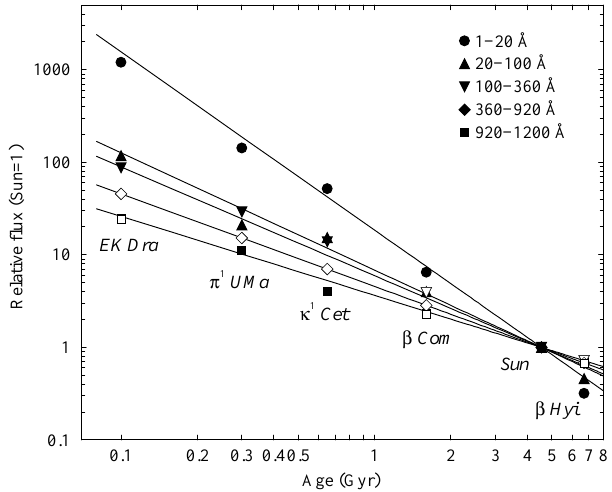
Figure 1. Solar-normalized fluxes (with respect to those of today) vs. stellar age for different wavelength bands for solar-type stars. Taken from Ribas et al.